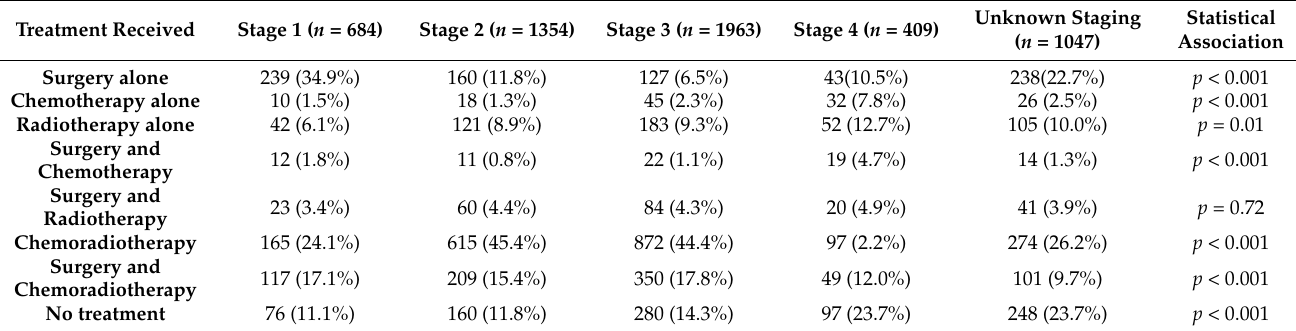
Table 2. Treatment modality received stratified by stage of patient at